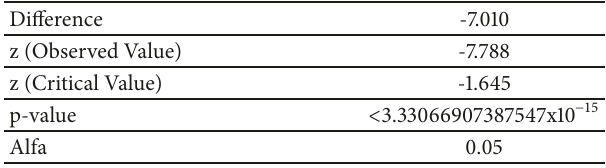
Figure 6: Modeling of systolic pressure with the MNN. Table 9: Results of the Z-test for Module